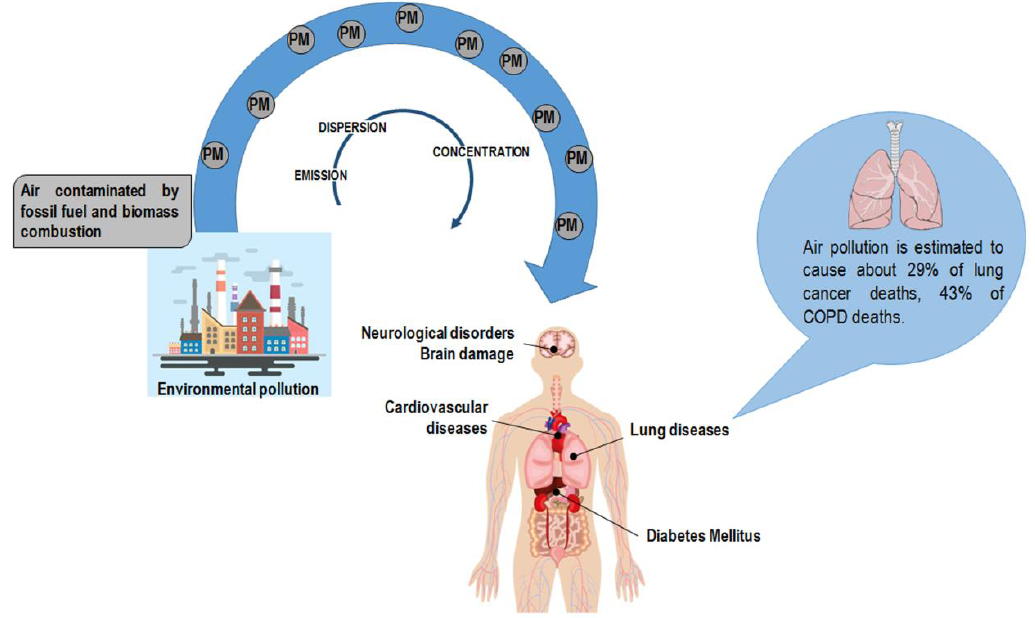
Figure 1. Anthropogenic activity is the primary source of particulate matter (PM) in the atmosphere. PM encompasses a mixture of elements, including arsenic, cadmium, and lead. Air pollution has a deleterious effect on human health exposing the organism to the risk of disease onset. Of note, air pollution is estimated to cause about 29% of lung cancer deaths and 43% of chronic obstructive pulmonary disease (COPD) deaths [19].